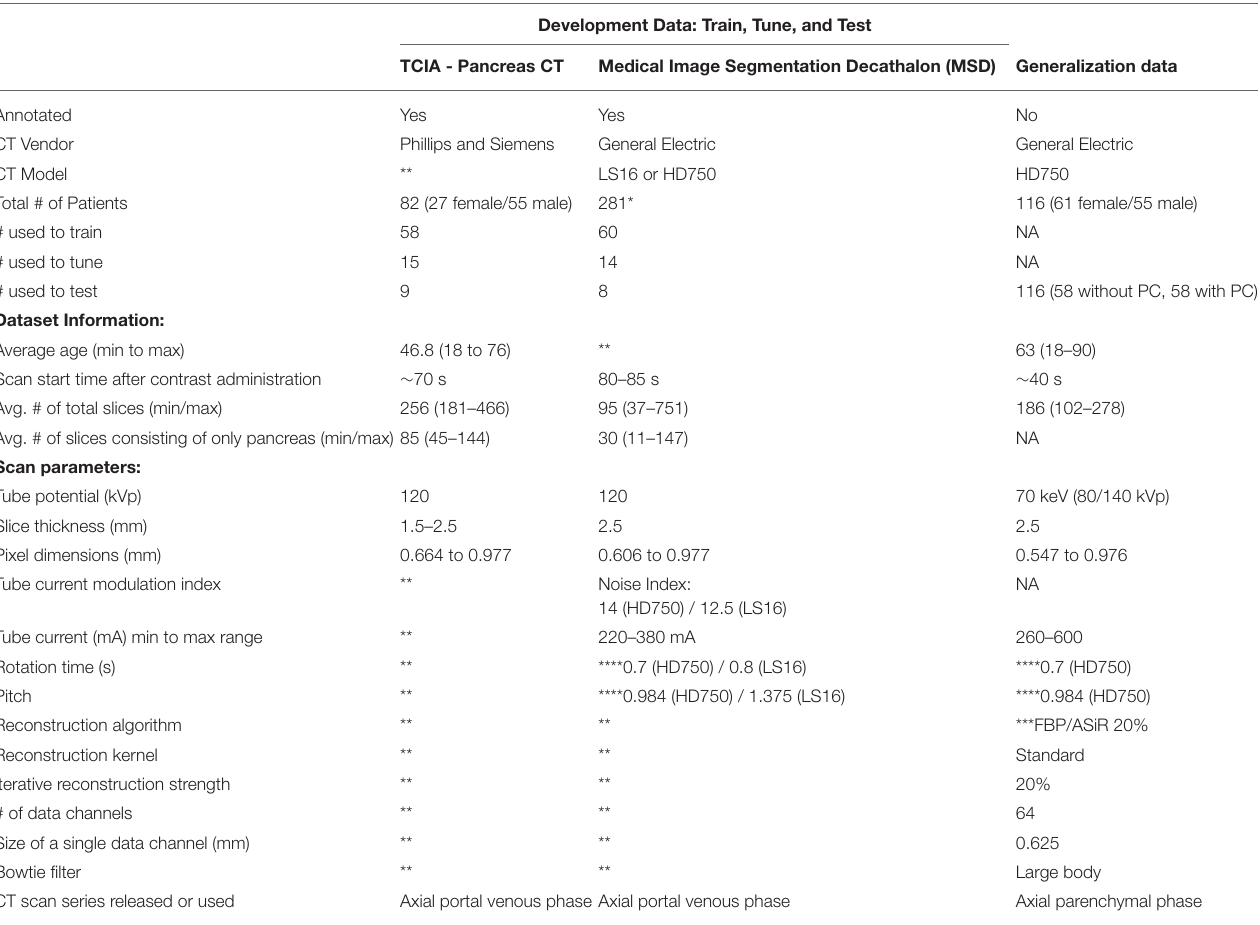
TABLE 1 | Scan parameters and patient-specific characteristics for development and generalization